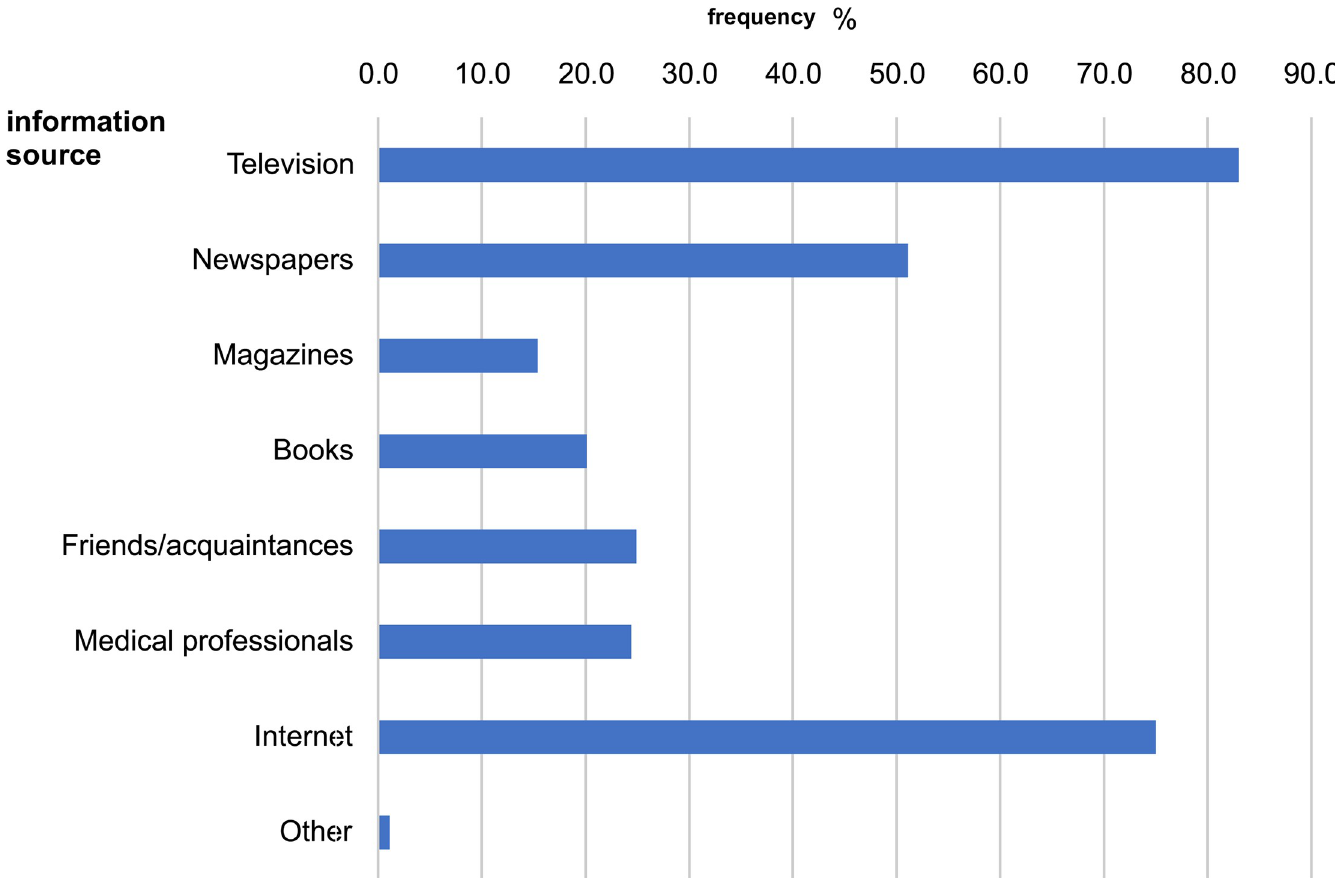
Fig 1. Sources of health and medical information.